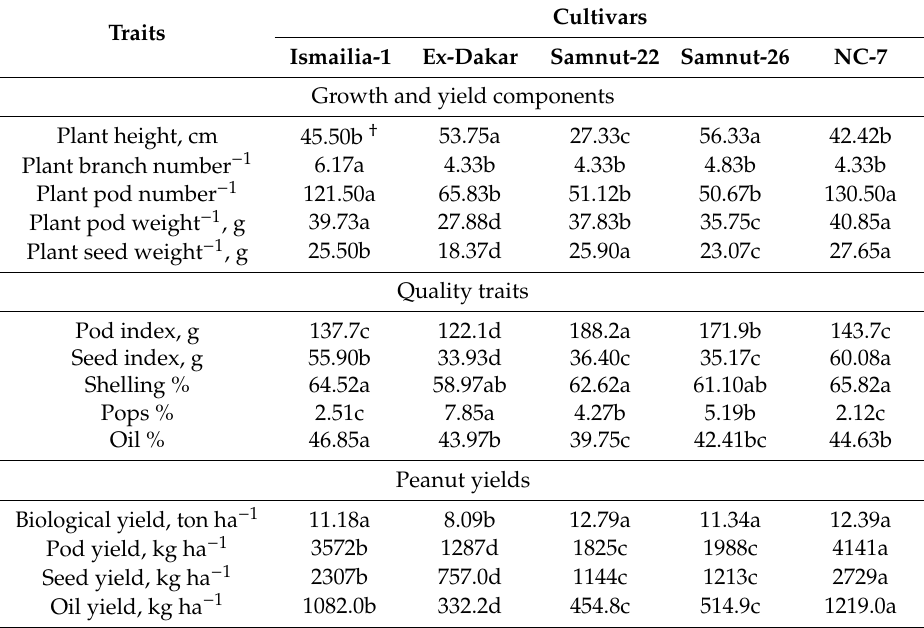
Table 4. Mean of studied traits of peanut treatments tested at field experiments in Giza, Egypt— combined data from 2016 and 2017